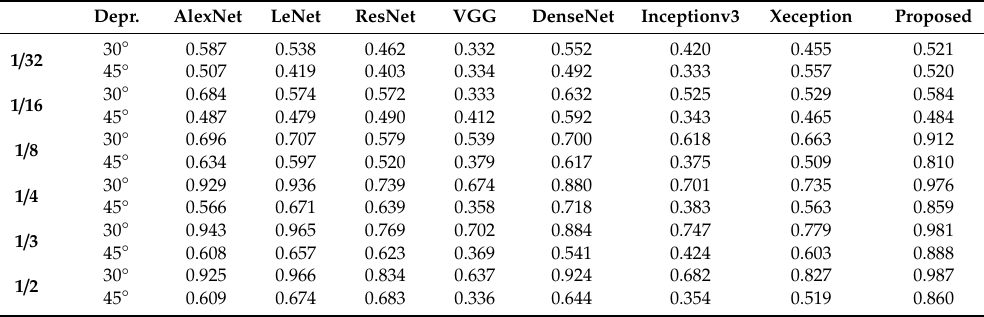
Table 16. Experiments under small established dataset on